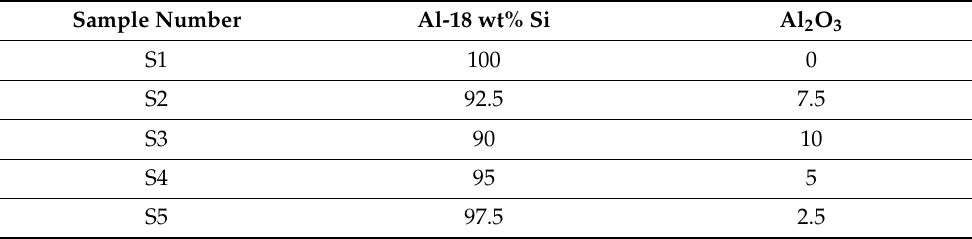
Table 1. Experimental layout as per Mixture